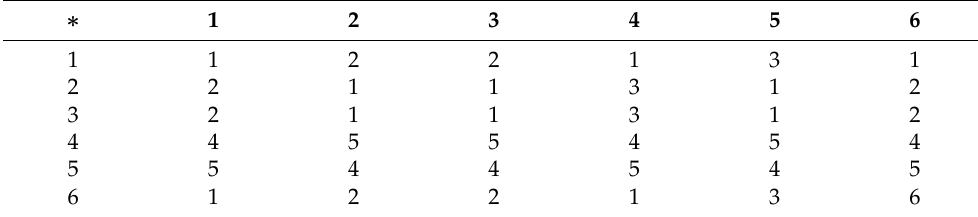
Table 6. A regular TA-groupoid of Example 4.